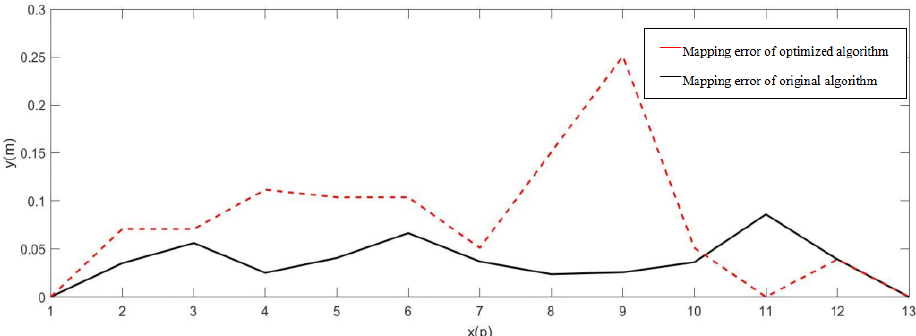
Figure 19. Error Analysis of Original Algorithm and Optimized